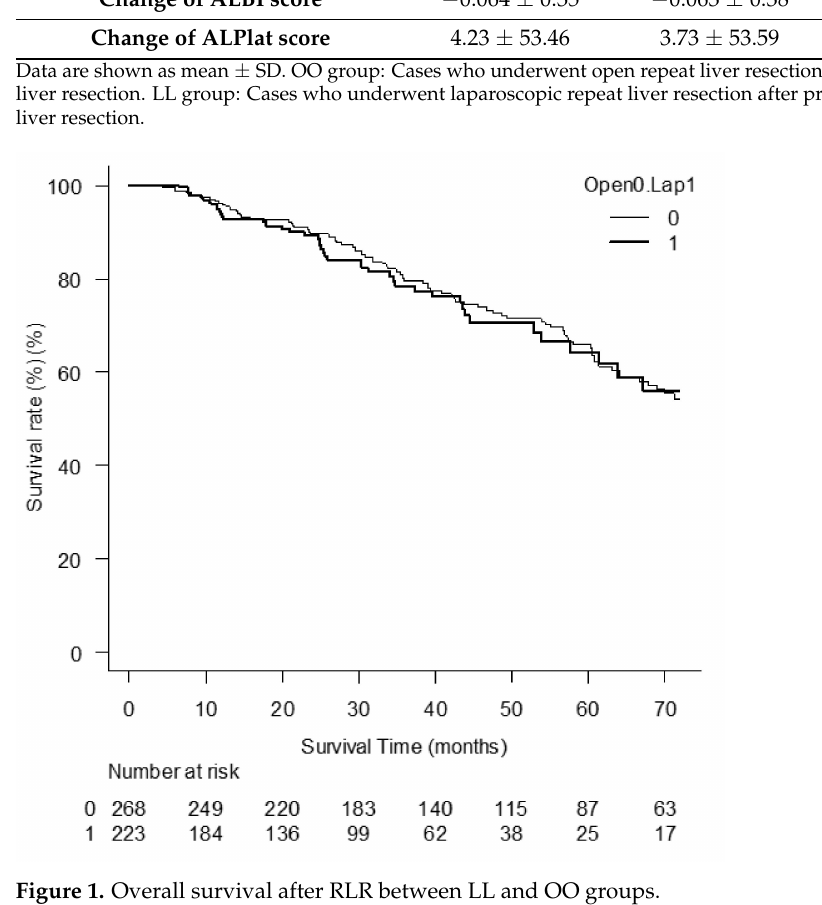
Figure 1. Overall survival after RLR between LL and OO